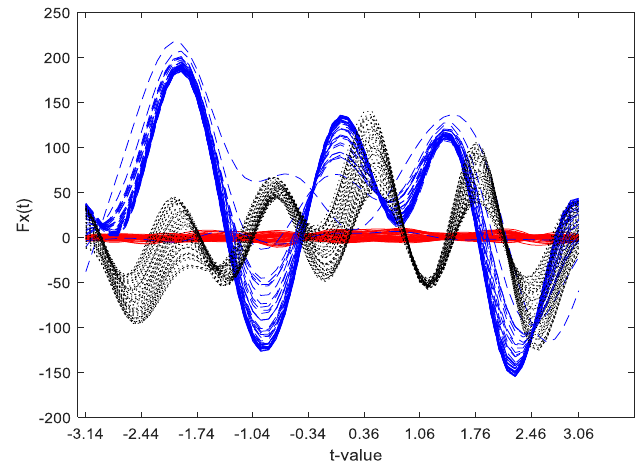
Figure 3. Andrews plot on a set of data from the CSTR system.